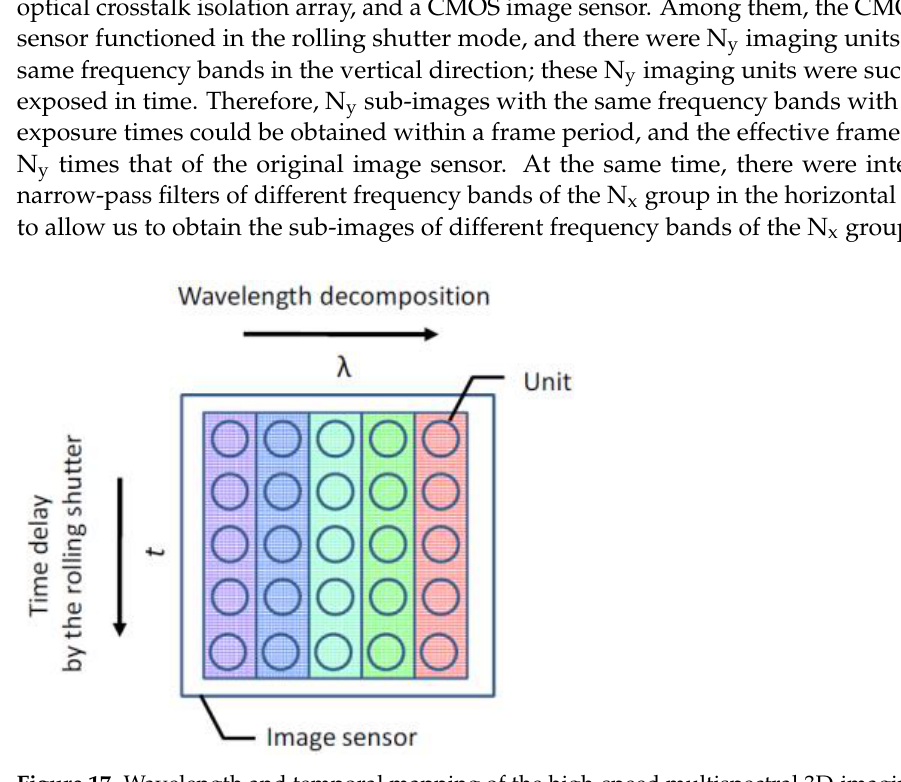
Figure 17. Wavelength and temporal mapping of the high-speed multispectral 3D-imaging system based on TOMBO.